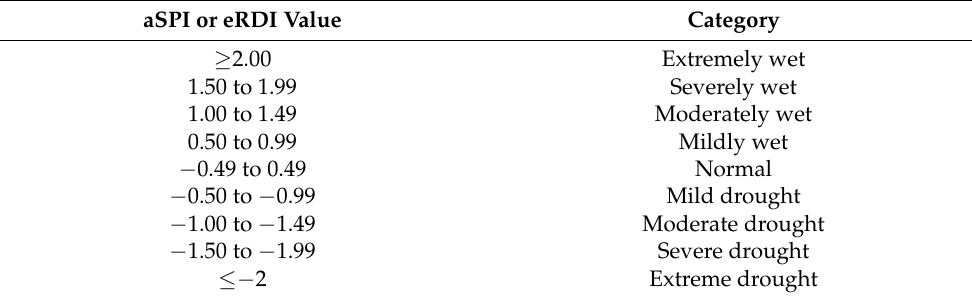
Table 1. Drought classes based on aSPI or eRDI